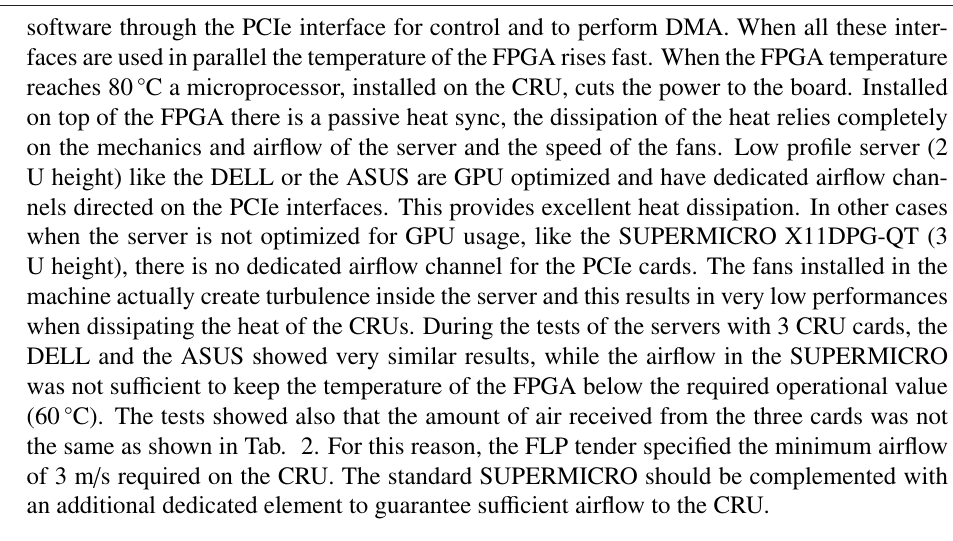
Table 2. Airflow speed at the output of the FAN and of the